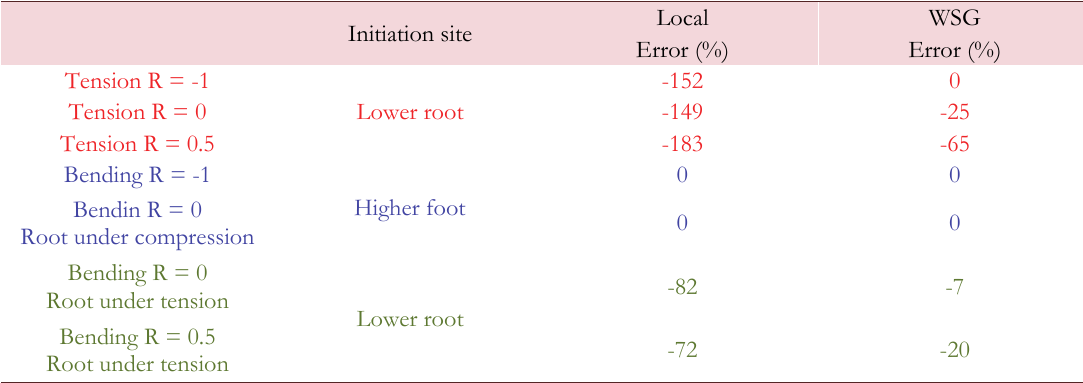
Figure 10: comparison between local criterion and WSG (Welded Stress Gradient) on different load